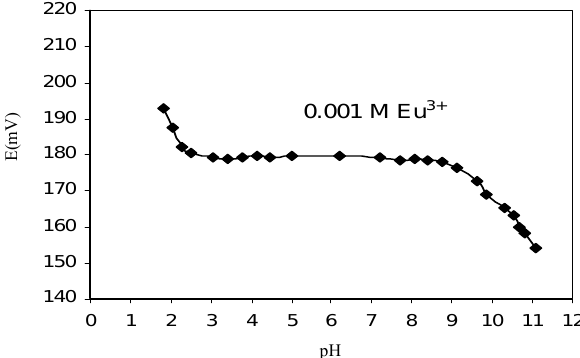
Figure 3. pH effect of the test solution (1.0 × 10 -3 M of Eu 3+ ) on the potential response